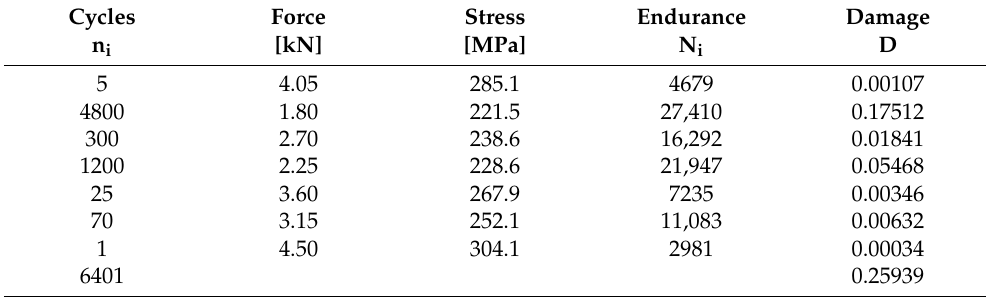
Figure 24. Von Mises stress–strain regression curves for ∆ σ i . For each geometry of the notch, the hotspot stress ( ∆ σ i ) for each cycle was assessed from the respective regression curve. The endurance (N i ) for each cycle was calculated using Formula (7), and the total damage for each cycle was calculated using Formula (8). The results of this procedure for the sharp notch are shown in Table 9. Table 9. Total damage for the sharp